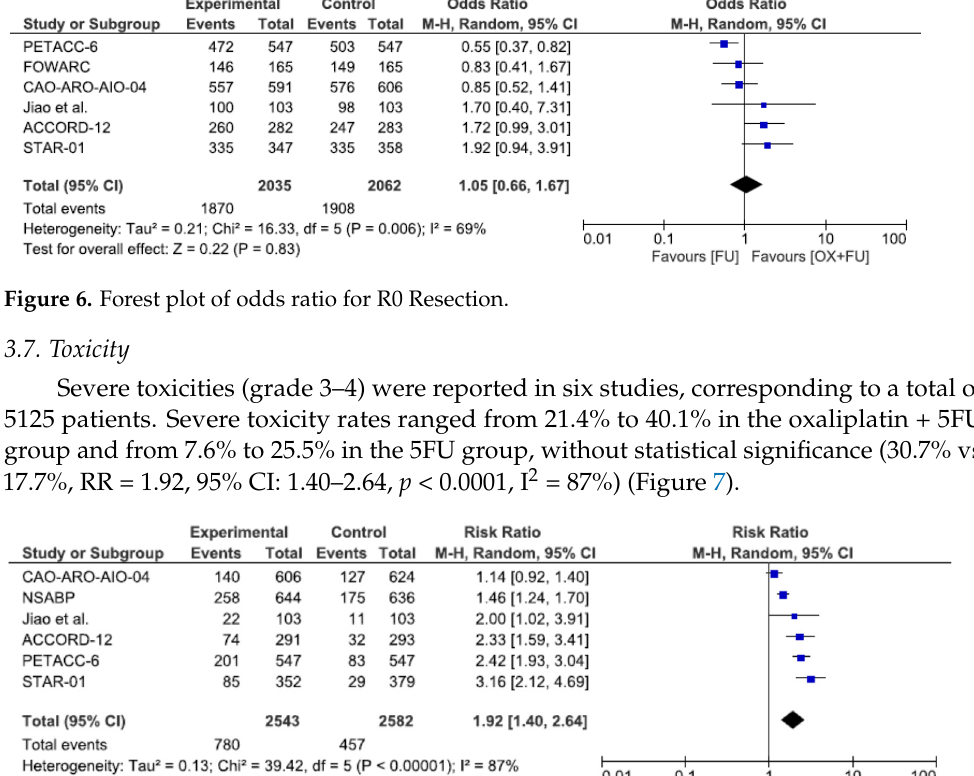
Figure 8. Forest plot of risk ratio for hematological toxicity. 3.9. Digestive Toxicity Severe diarrhea toxicities (grade 3–4) were reported in seven studies, corresponding to a total of 5455 patients. Severe diarrhea toxicity rates ranged from 12.1% to 18.5% in the oxaliplatin + 5FU group and from 3.1% to 9.7% in the 5FU only group, with a significantly higher rate in the oxaliplatin + 5FU group (15.1% vs. 6.4%, RR = 2.41, 95% CI: 1.74–3.32, p < 0.00001, I 2 = 68%) (Figure 9). Figure 9. Forest plot of risk ratio for digestive toxicity.